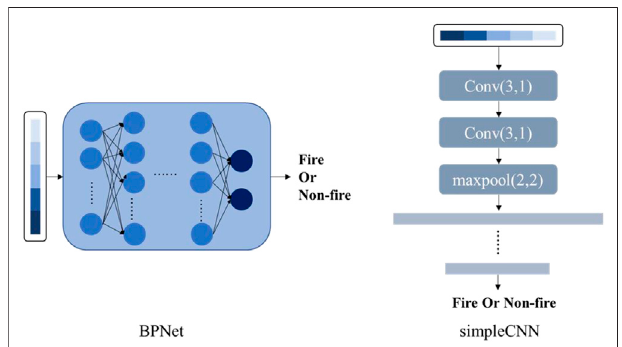
FIGURE 4 | The structure of BPNet and